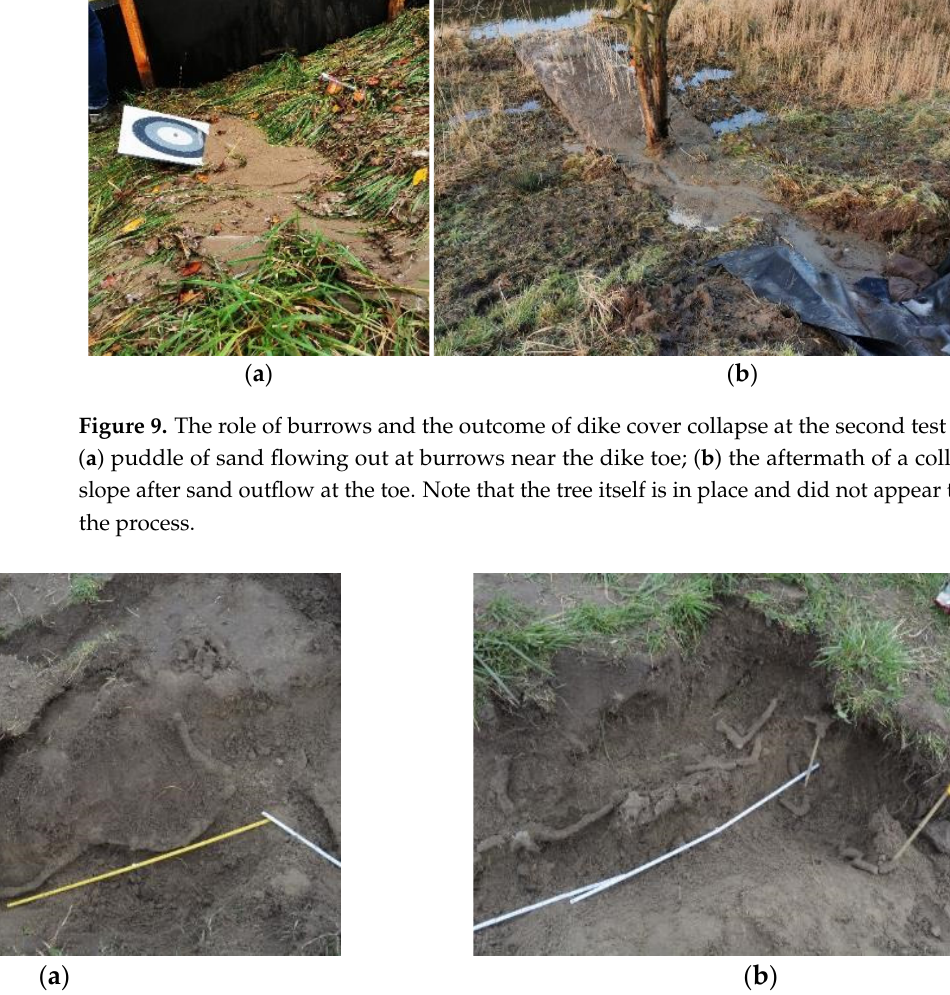
Figure 9. The role of burrows and the outcome of dike cover collapse at the second test with a tree: ( a ) puddle of sand flowing out at burrows near the dike toe; ( b ) the aftermath of a collapsed dike slope after sand outflow at the toe. Note that the tree itself is in place and did not appear to influence the process.